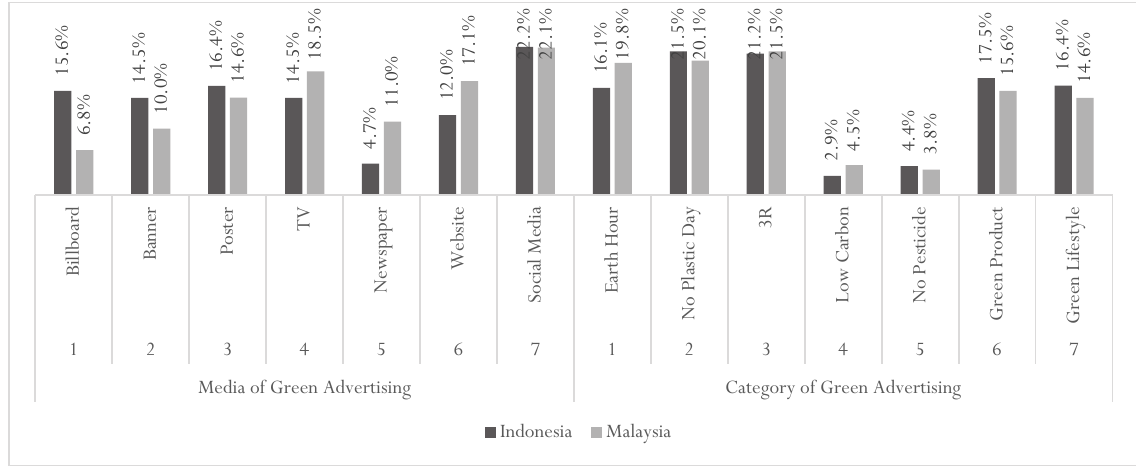
Fig. 2. Green Advertising Perception in Indonesia and Malaysia